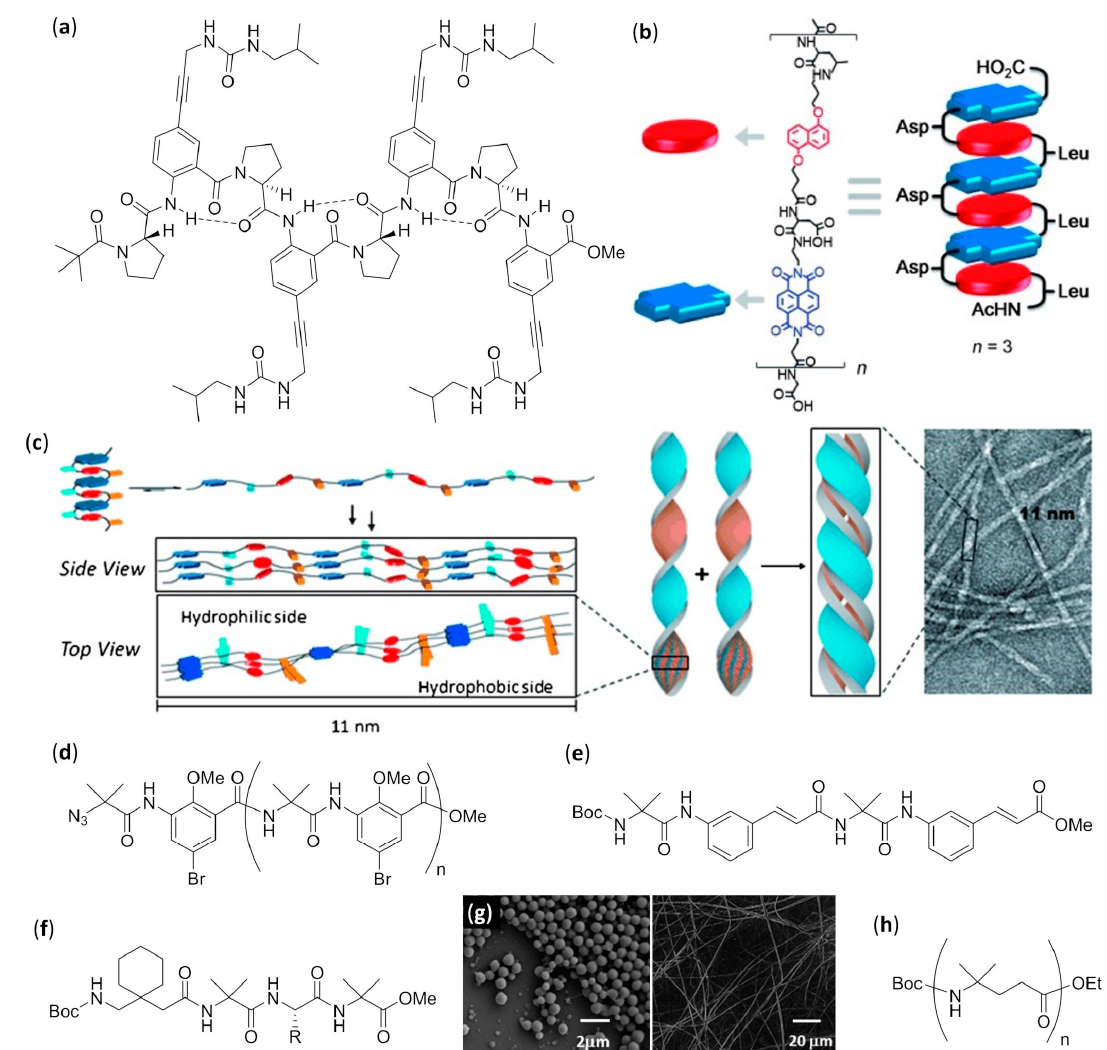
Figure 22. ( a )StructureofPiv-(Pro-Ant) 4 -OMefoldamerwiththehydrogenbondingpattern(Refs.[246,247]); ( b ) Folding of stacked DAN–NDI amphiphilic foldamer (DAN in red; NDI in blue) (adapted with permission from Ref. [250]); ( c ) Proposed model for the formation of fibrils from DAN–NDI amphiphilic foldamer upon heating—after unfolding of face-centered DAN–NDI stacked foldamers, the formation of amphiphilic ribbons occurs, which in turn self-assemble by burying leucine side chains in the interior, thus minimizing the lipophilic surface exposed to the aqueous environment, while the hydrophilic aspartate side chains are faced toward the solvent (DAN and NDI units are reported as in panel ( b ), while light blue rectangles are aspartate side chains and orange rectangles are leucine side chains) (adapted with permission from Ref. [250]); ( d ) General structure of Aib-Amb α / γ -foldamers (n = 0, 1, 3 and 7) (Ref. [252]); ( e ) Structure of Boc-(Aib-Aca) 2 -OMe α / ε -foldamer (Ref. [254]); ( f ) General structure of Boc-Gpn-Aib-Xaa-Aib-OMe α / γ -foldamers (Ref. [256]); ( g ) SEM images of (left) microspheres formed by the unsaturated α , ε -hybrid tetrapeptide and (right) ribbon-like entangled fibers formed in p -xylene by the saturated α , ε -hybrid tetrapeptide (adapted with permission from Ref. [254]); ( h ) General structure of Boc-Aic n -OEt γ -foldamers (Ref.